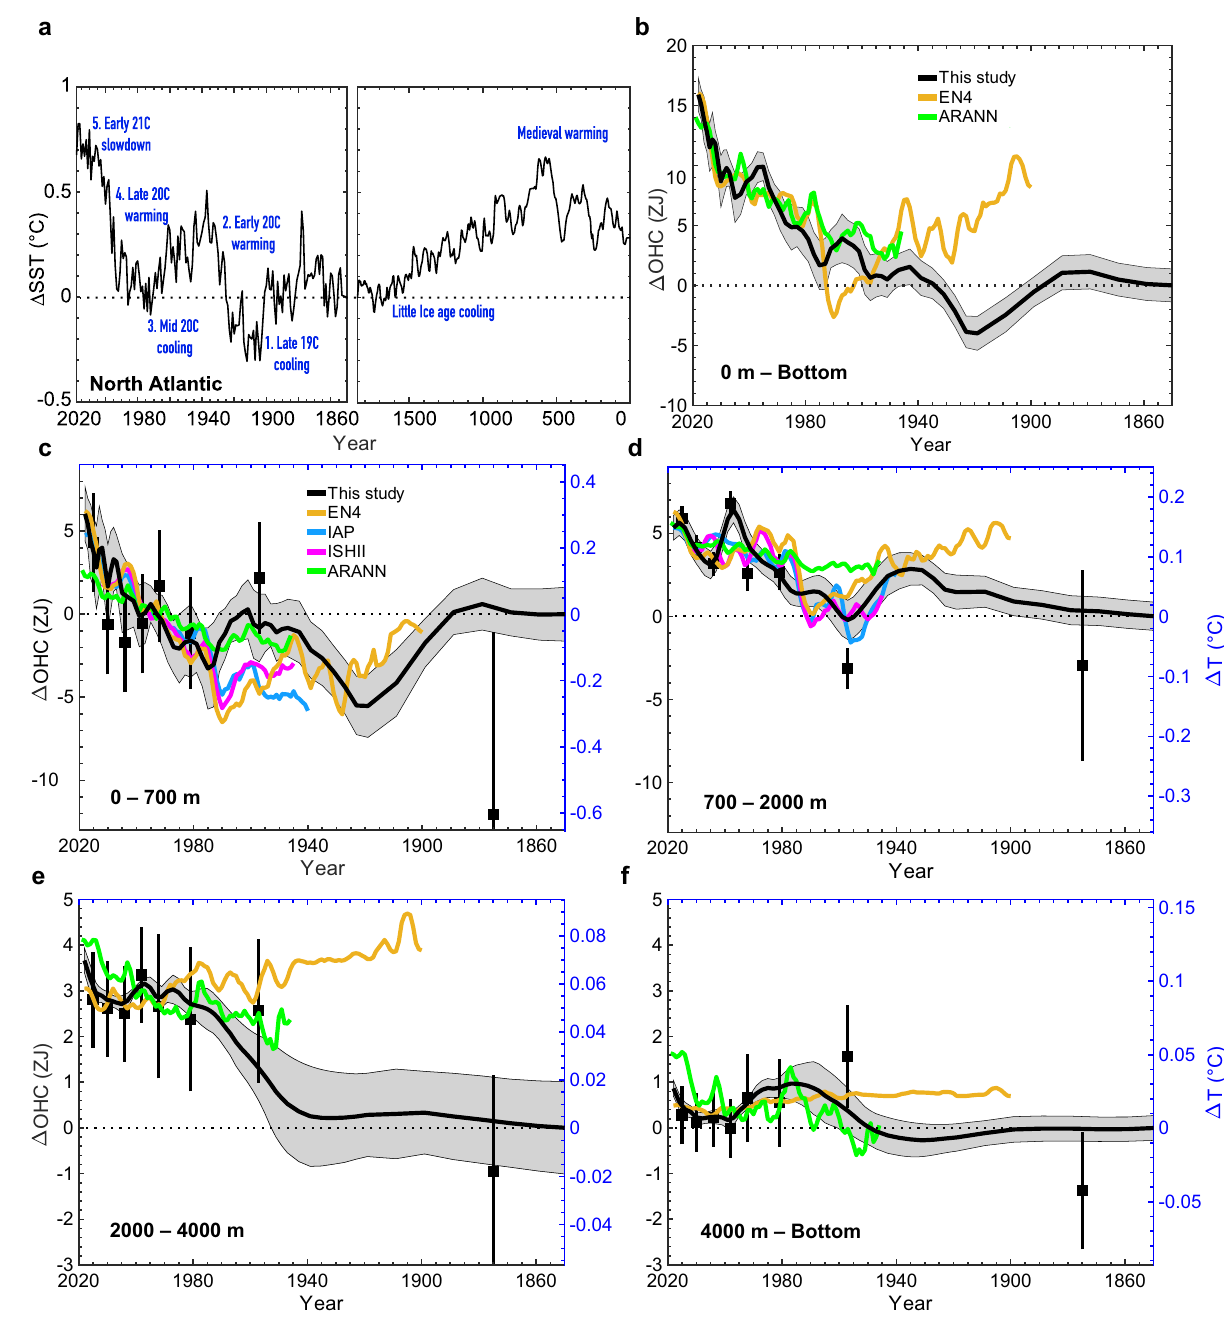
Fig. 2 Reconstructions of temperature and OHC changes at 25°N with comparison to hydrographic surveys and reanalyses. a Time series of North Atlantic (0 – 89°N) ERSSTv5 Δ SST (left panel) for years 1854 to present and of global mean Δ SST EQ – 0015 15 (right panel) for years 0 to 1854 (see Data). Recent climate periods are adapted from Yao et al. 89 . b – f Time series of zonally and vertically averaged temperature anomaly ( Δ T in °C, right y -axis) and section-integrated ocean heat content anomaly ( Δ OHC in ZJ = 10 21 J, left y -axis) for our reconstruction (black) and ocean reanalyses (ORAs; EN4 (orange), IAP (cyan), ISHII (magenta) and ARANN (green), see Data). b shows the full water column ( Δ OHC only) and the four depth ranges are displayed in ( c ) top 700 m, ( d ) 700 – 2000m, e 2000 – 4000 m, ( f ) 4000 m – bottom. ORAs are the mean for the 20°N – 30°N latitude band, and for comparison, our Δ OHC reconstructions at 25°N are extrapolated in latitude by 10 degrees to cover the band 20°N – 30°N. The ORAs are referenced to our 1981 – 2010 baseline mean. The grey shading shows the one standard deviation of the temperature estimated from the 5005-member ensemble computed using the fi ve different cruises and 1001 different SSTs ( ‘ Methods ’ ). The squares with error bars are the hydrography-based values corrected for the different cruise tracks (Supplementary Note